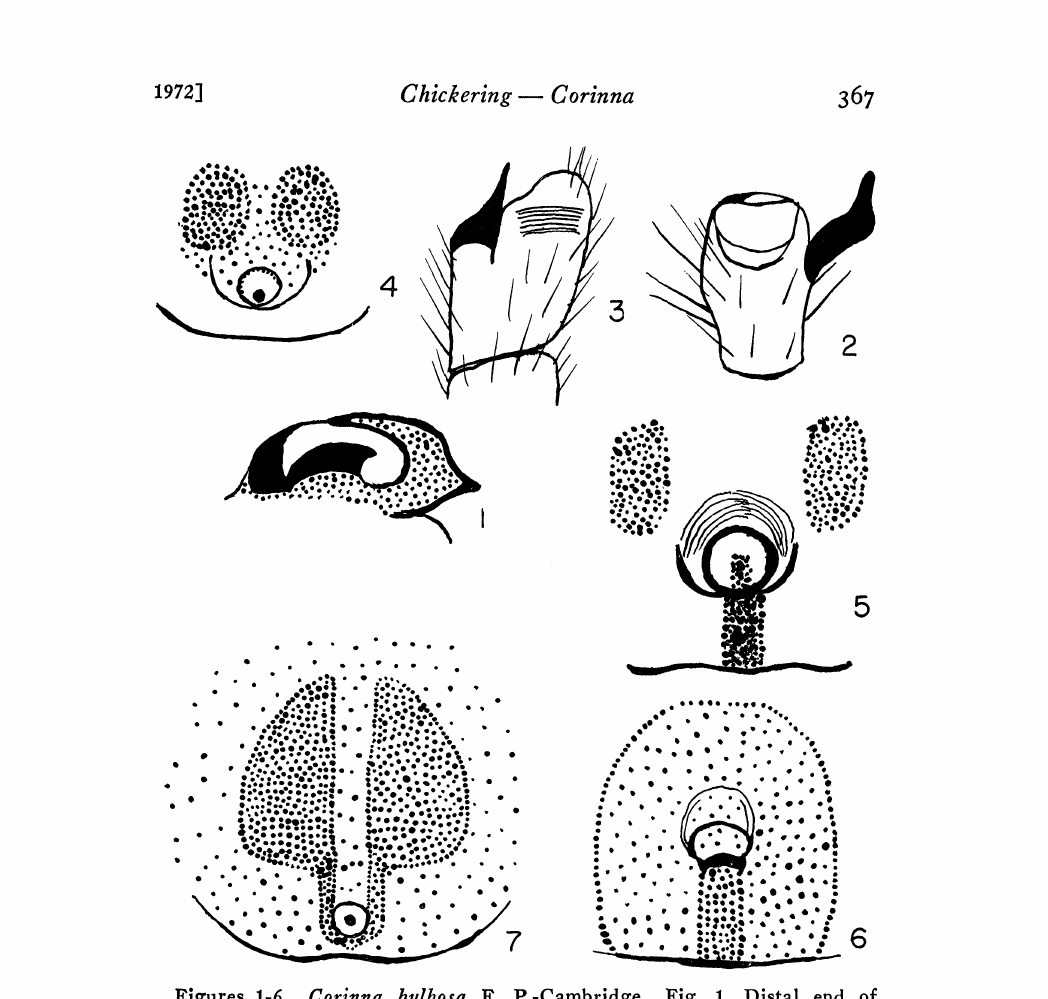
Figures 1-6. Corinna bulbosa F. P.-Cambridge. Fig. 1. Distal end of left palpal tarsal bulb removed from eymbium. Figs. 2-3. Left palpal tibia; prolateral and retrolateral views, respectively. Figs. 4-6. Epigyna from below showing variation in appearance. Figure 7. Corinna terida sp. nov.; epigynum of holotype from